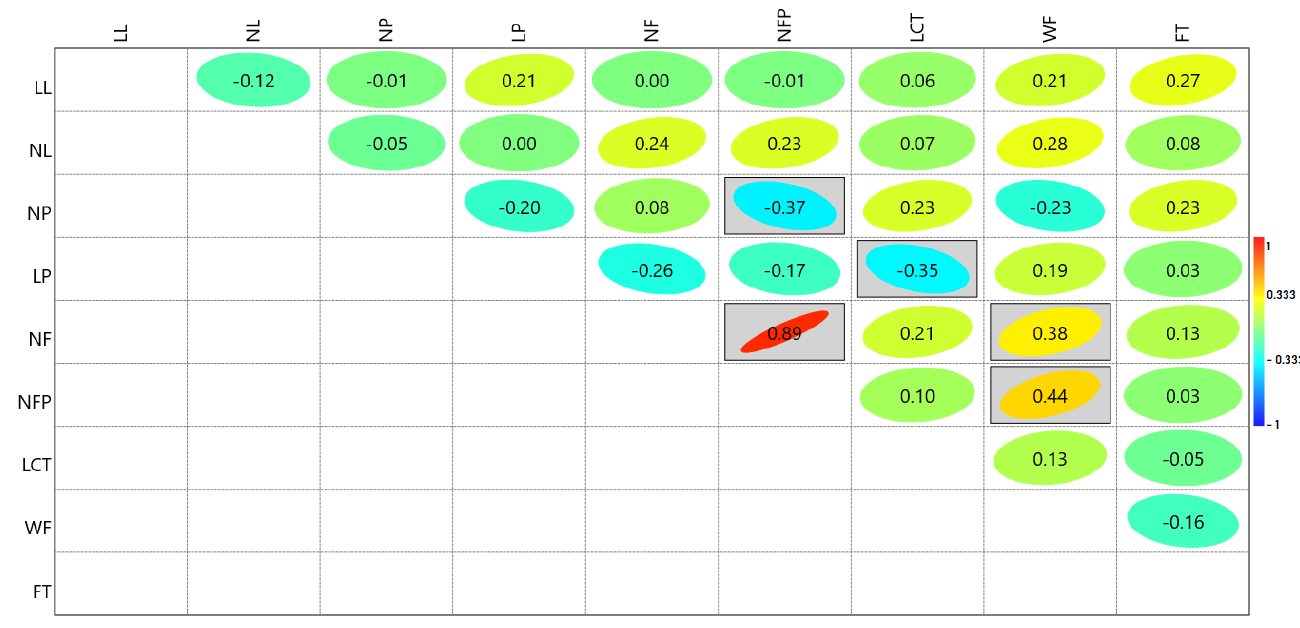
Figure 3. Pearson correlation coefficients (‘r’ value) between the mean values of the morphological parameters of F 1 plants from P1×P2 cross. LL—length of leaf (cm); NL—number of leaves; NP—number of peduncle/plant; NF—number of flowers/plant; NFP—number of flowers/peduncle; LCT—length of corolla tube (cm); WF—width of flower (cm); FT—flowering time (days). The color intensity of the ellipses is directly correlated to the correlation coefficient value. The boxes with a grey border illustrate statistically assured values of “r” at a p -level below 0.05.